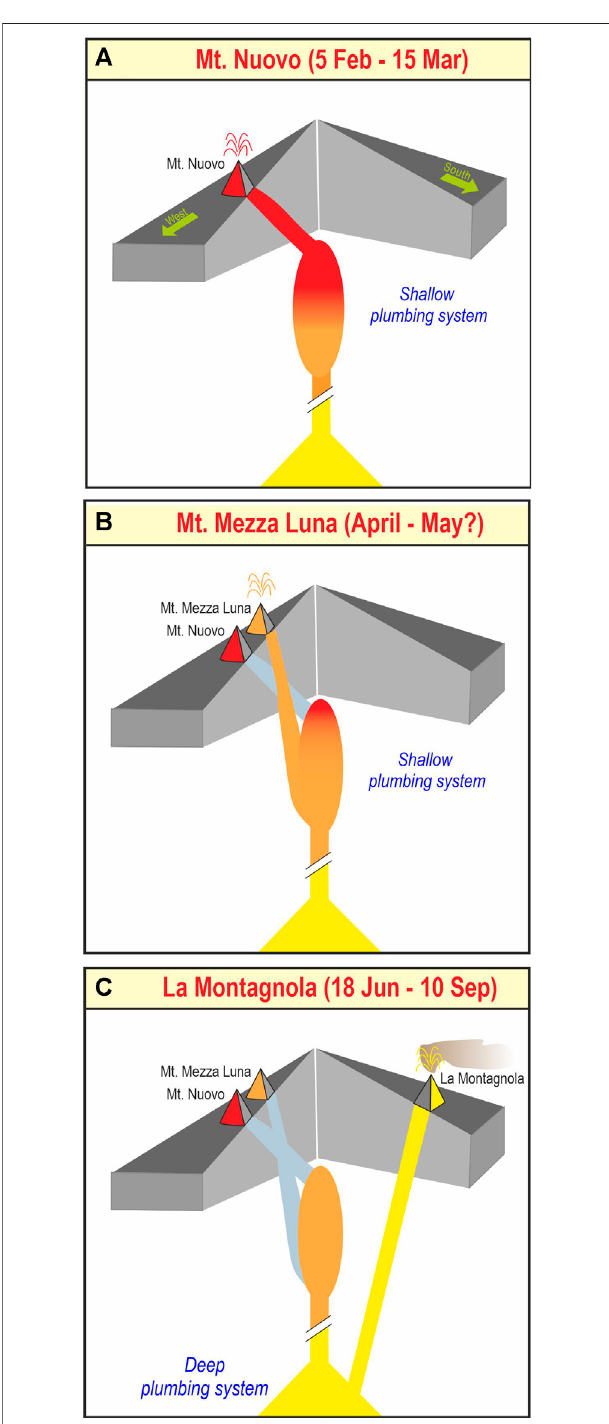
FIGURE 6 | Cartoon illustrating magma dynamics of Etna plumbing system driving the eruptions of Mt. Nuovo (A) , Mt. Mezza Luna (B) and La Montagnola (C) in 1763. See text for